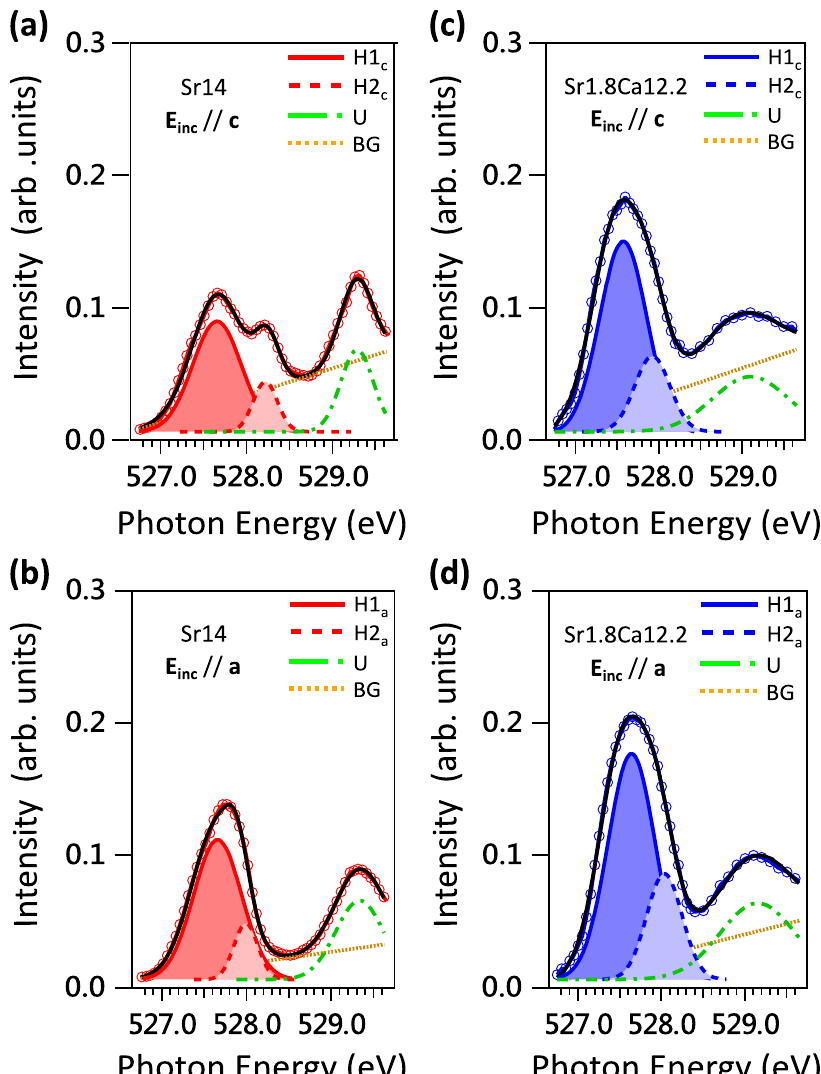
Fig. 3 Evaluated ladder hole concentration with Ca-doping effects. O K -edge XAS spectra with fi tting components for ( a – b ) Sr14 and ( c – d ) Sr1.8Ca12.2. A linear background ( BG ) is applied in the spectral fi tting. The spectral weight at 527.5, 528.2 and 529.25 eV, respectively, represent the chain hole content H 1, the ladder hole content H 2, and the upper Hubbard band 28,29,31 . The polarization of incident X-rays is parallel to the leg c-direction in ( a , c ), whereas ( b , d ) are measured in the rung a-direction con fi